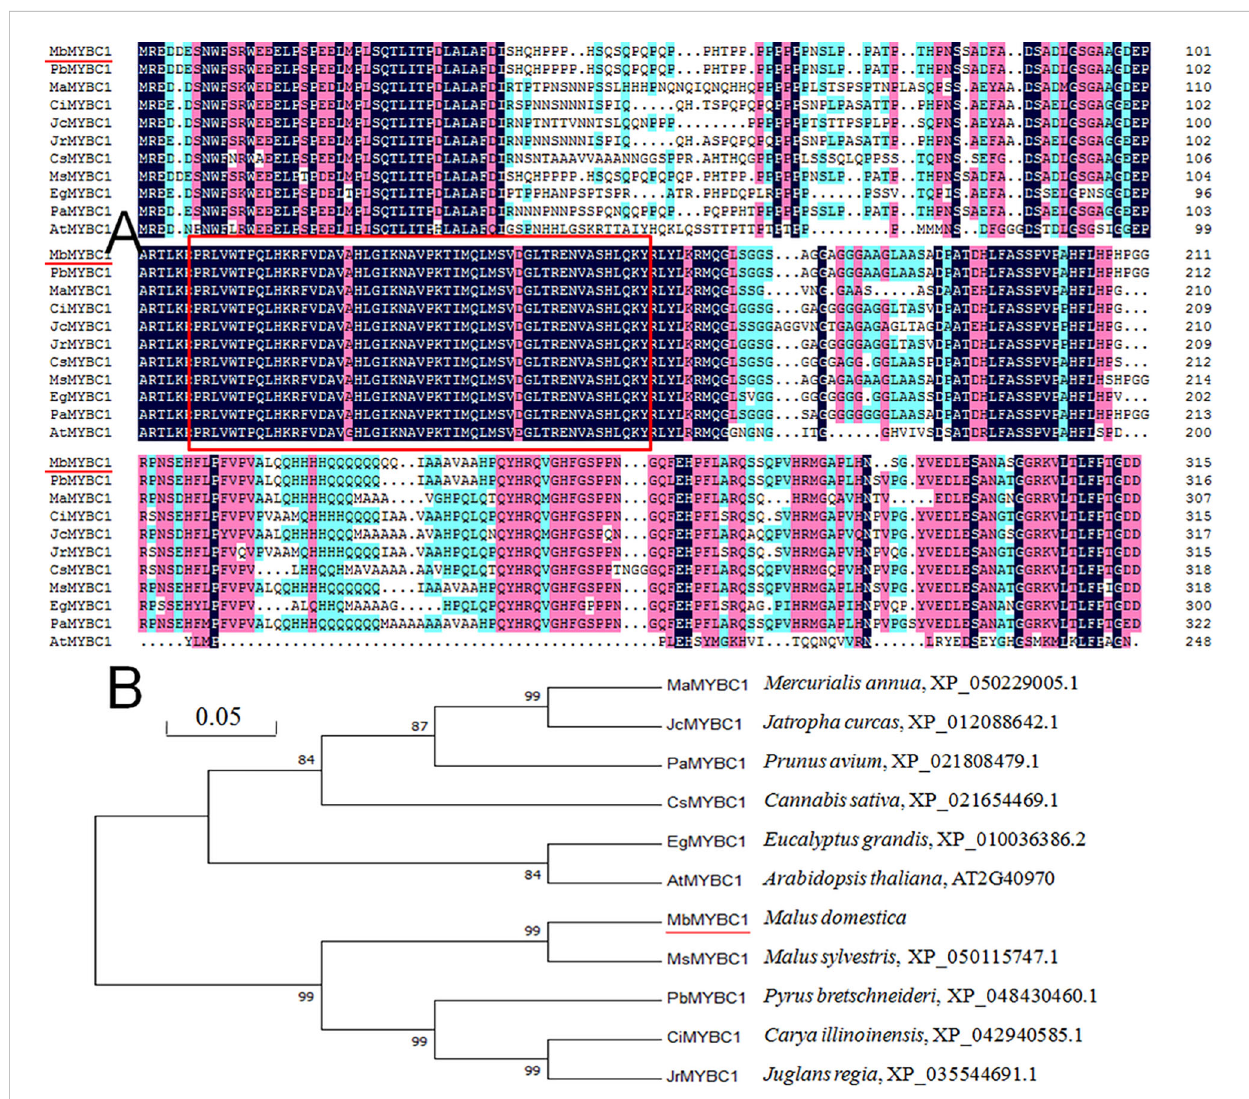
Figure 3 showed the distribution of 35s::MbMYBC1::GFP under the confocal microscope. The green fl uorescence of